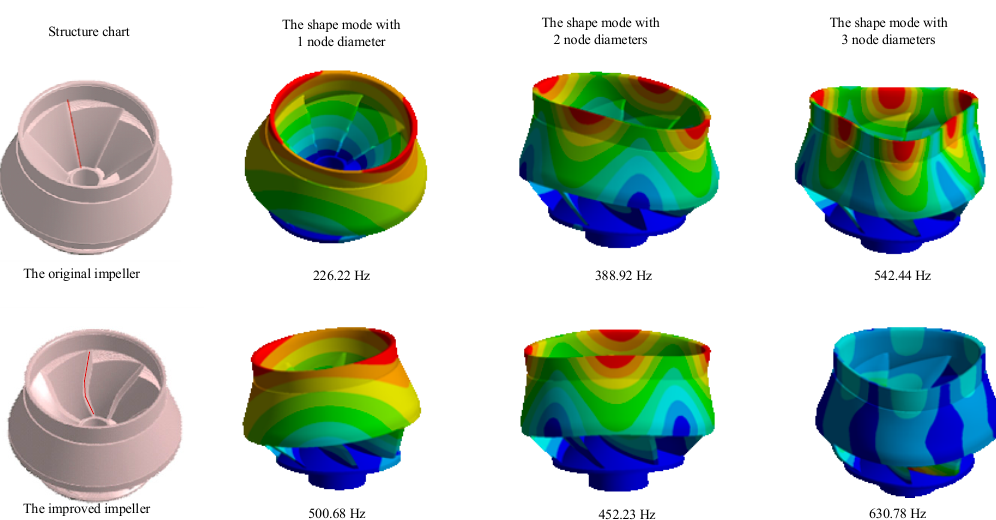
Figure 6. Comparison of natural vibration modes before and after impeller improvement.